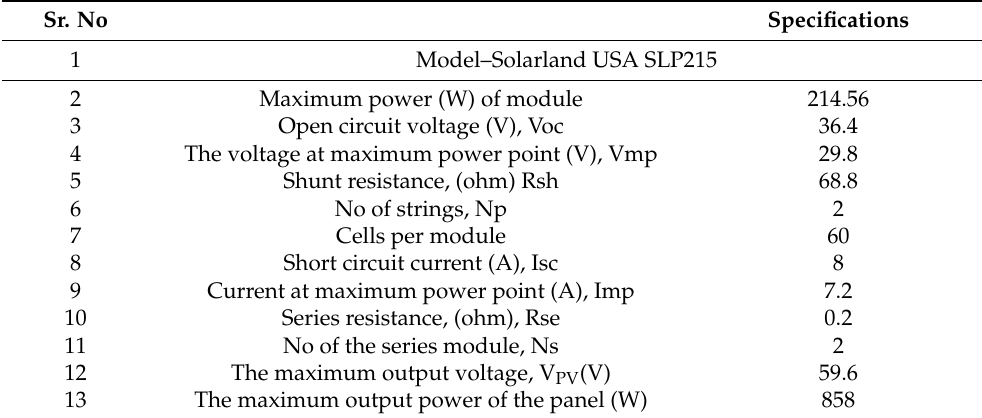
Table 8. Solar PV system specifications for the MPPT